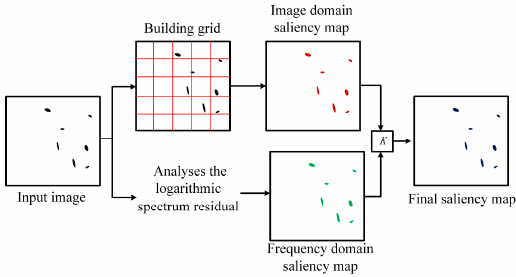
Figure 1. The flow chart of the improved visual attention mechanism.